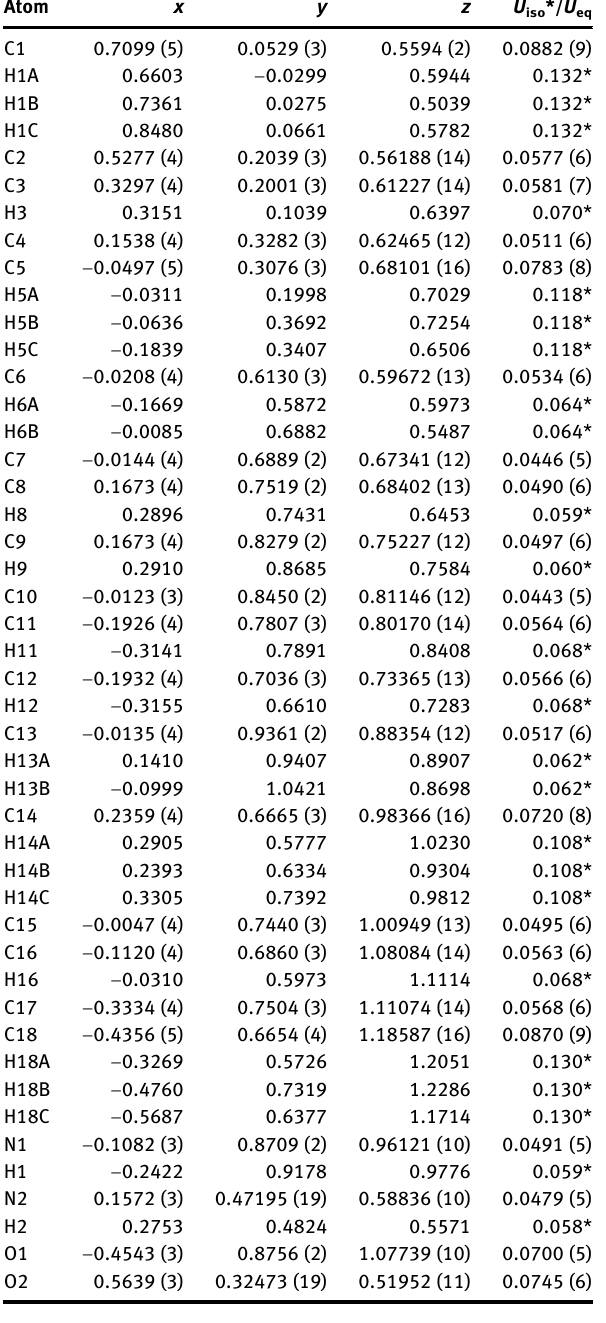
Table  : Fractional atomic coordinates and isotropic or equivalent isotropic displacement parameters (Å 